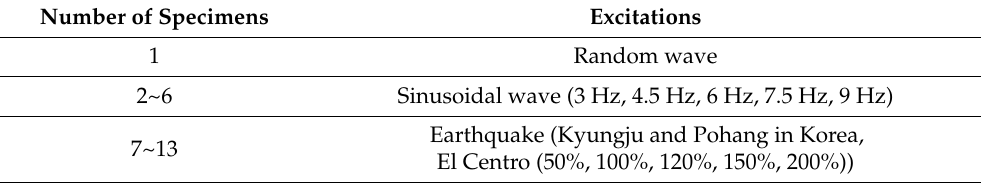
Table 4. Thirteen excitations.